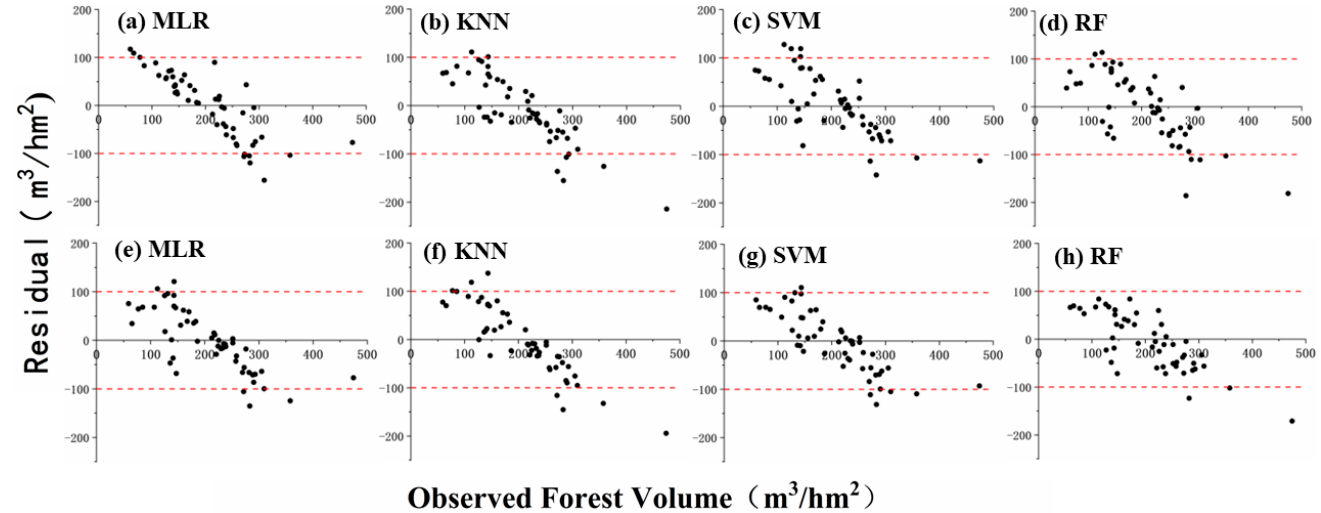
Figure 10. Scatter plots of errors between ground-measured and predicted GSV with different feature selection methods and models; ( a – d ) show results from GF-1 images using Pearson correlation and ( e – h ) show the results from GF-1 images using the proposed method.